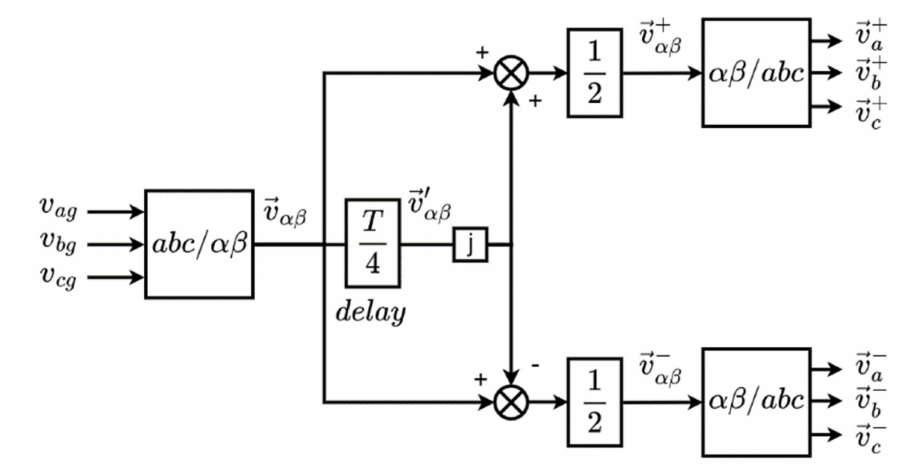
Figure 3. Sequence extraction